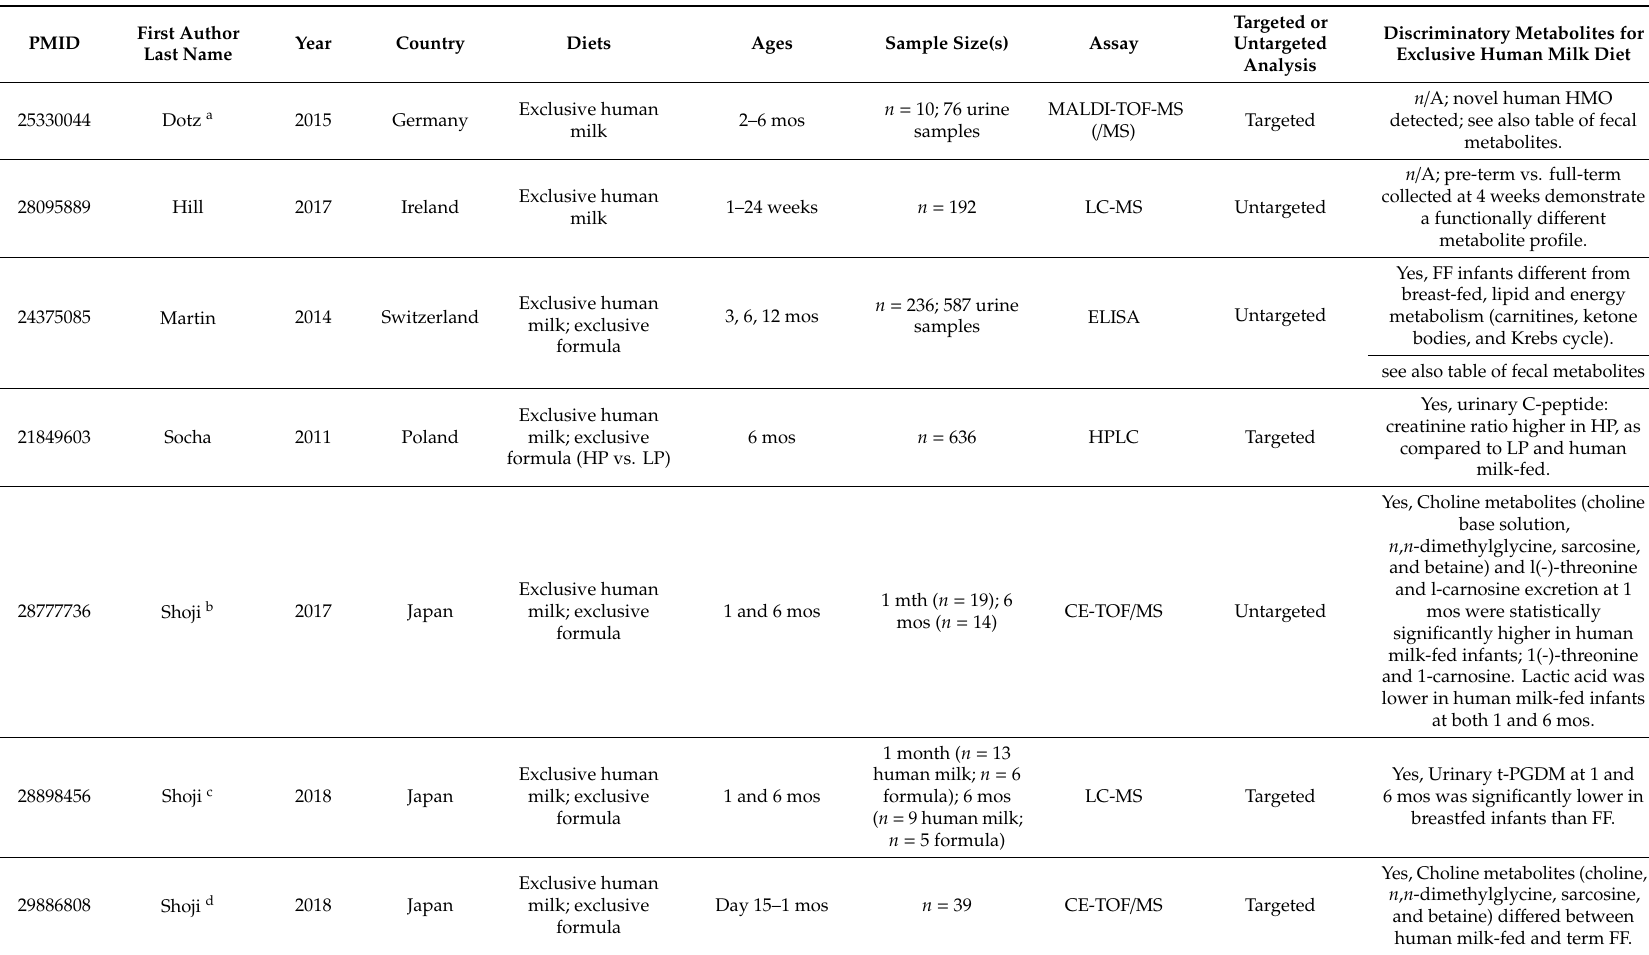
Table 4. Manuscripts reporting urine metabolites from human milk- and / or formula-fed infants ( n =